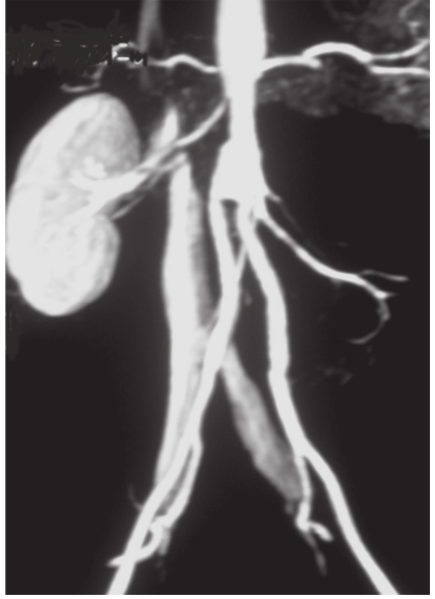
Figure 4 - Postoperative magnetic resonance angiography showing the aortobiiliac graft, without